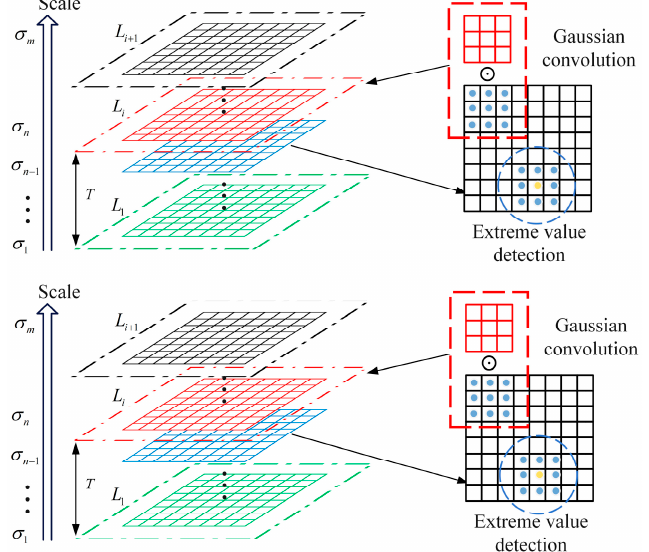
Figure 2. Constructing MTF scale space.